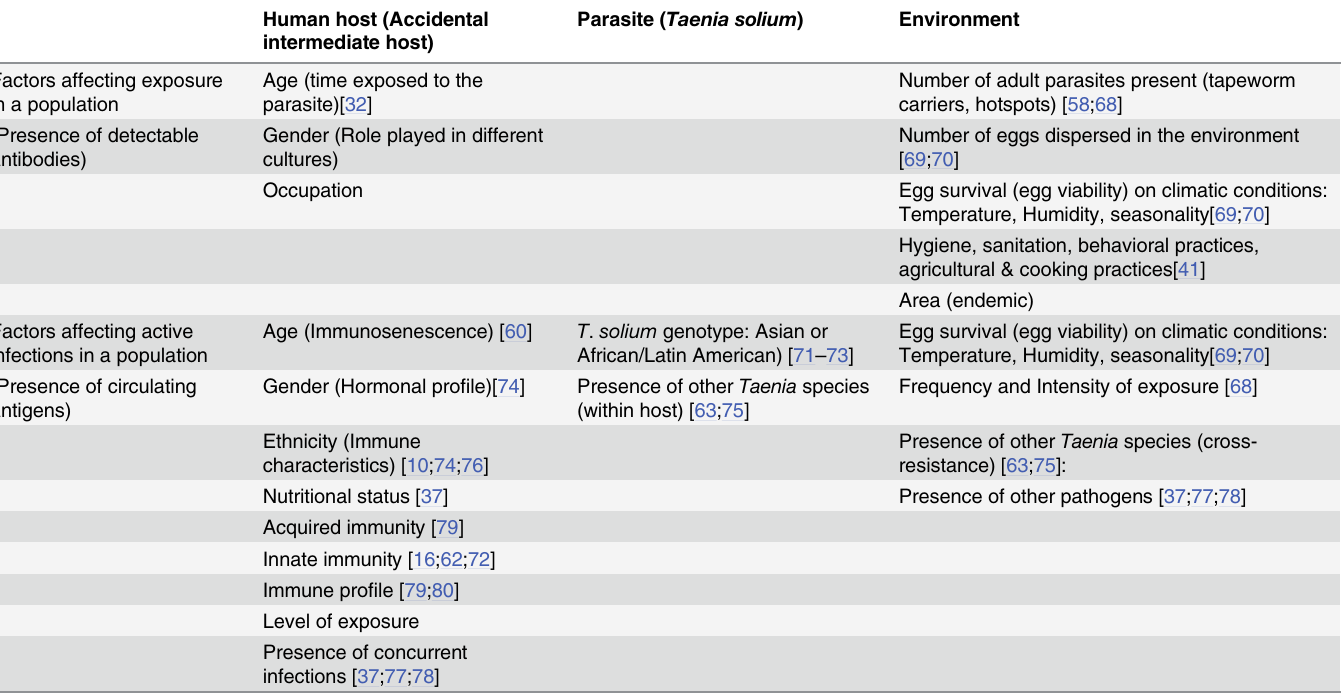
Table 5. Factors affecting serological variations of human cysticercosis infection and exposure to T . solium